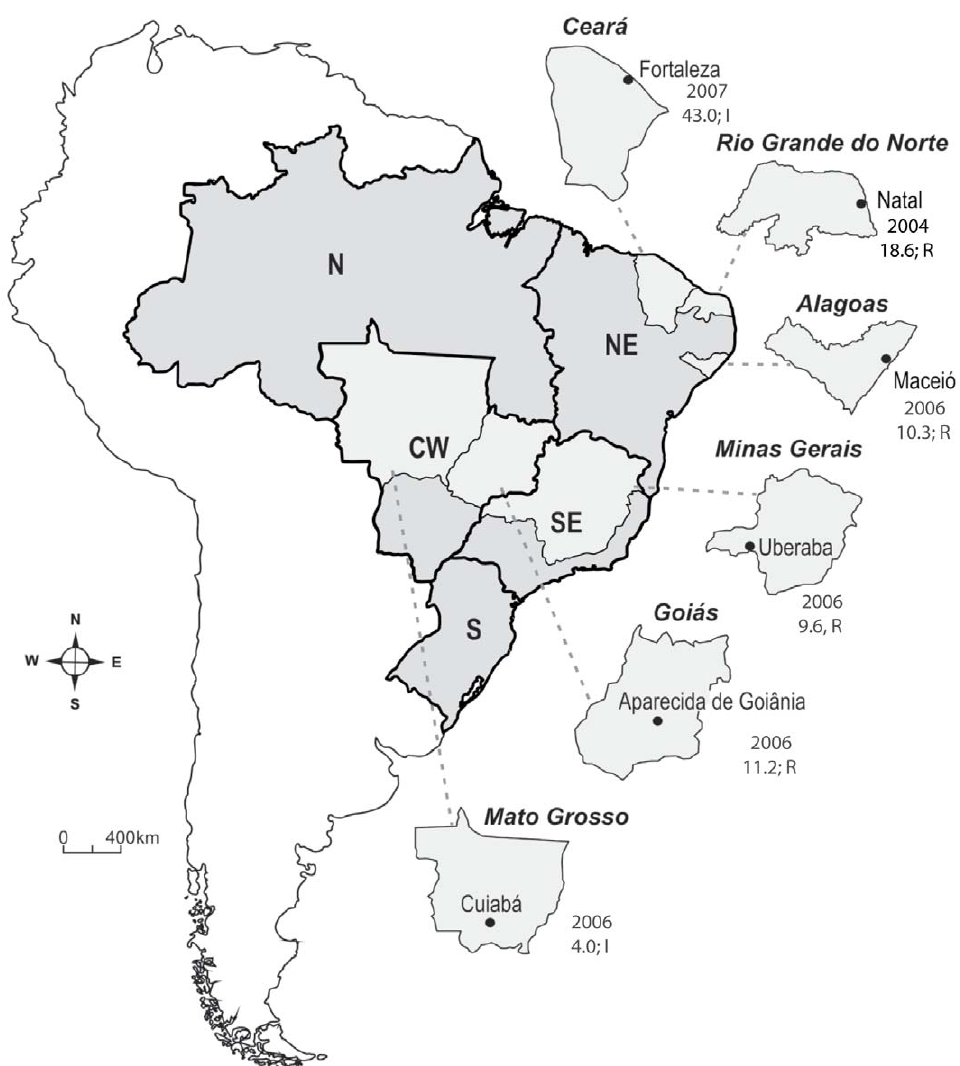
Figure 9. Original localities of Aedesaegypti studied populations. Brazilian map showing the States and municipalities used in the study. Bold lines indicate the different geographical regions of the country: N=North, NE=Northeast, SE=Southeast, S=South, CW=Central-Western regions. Numbers below each locality indicate, respectively, the collection year and the Resistance Ratio (RR 95 ) to temephos; ‘‘R’’ and ‘‘I’’ refer to the pyrethroid status. See Materials and Methods for details.